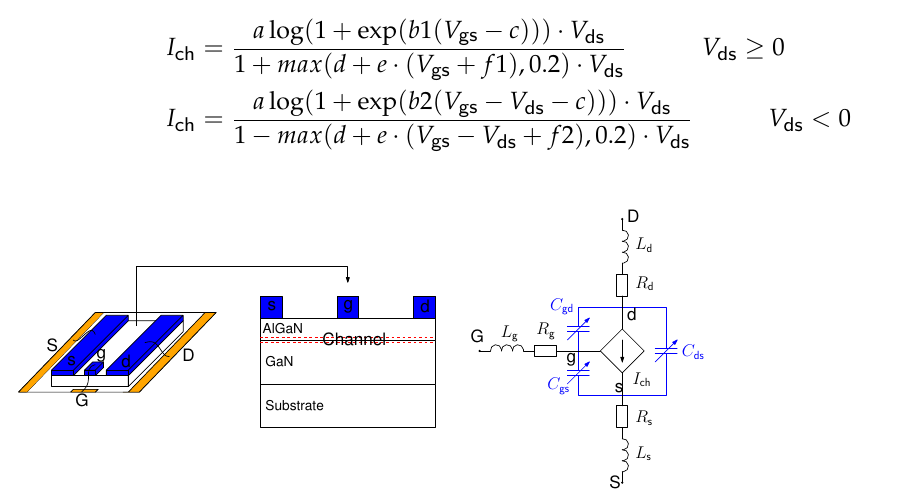
Figure 1. GaN-HEMT compact model by equivalent circuit.